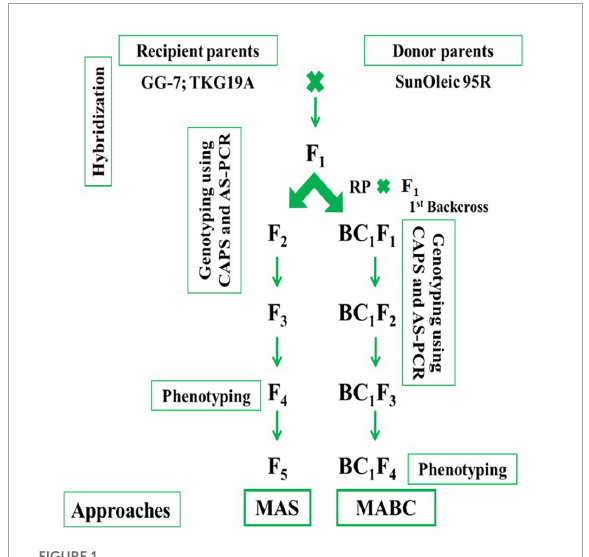
FIGURE1 Schematic diagram of molecular breeding approaches.